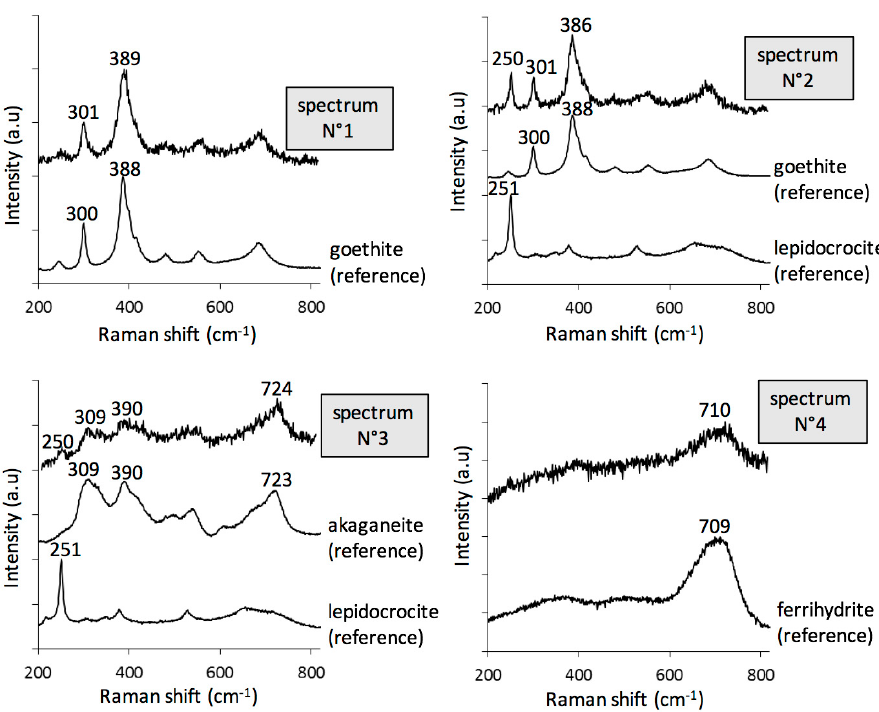
Figure 5. Set of Raman spectra acquired on the corrosion product layer. Each spectrum is plotted together with the corresponding ‘reference’ spectra. (spectrum n°1): goethite; (spectrum n°2): blended goethite/lepidocrocite; (spectrum n°3): blended akaganeite/lepidocrocite; (spectrum n°4): ferrihydrite. Maghemite ( γ -Fe 2 O 3 ) that presents a sharp double peak at 670 and 720 cm − 1 , is very different and hematite ( α -Fe 2 O 3 ) were not detected in the CPL.